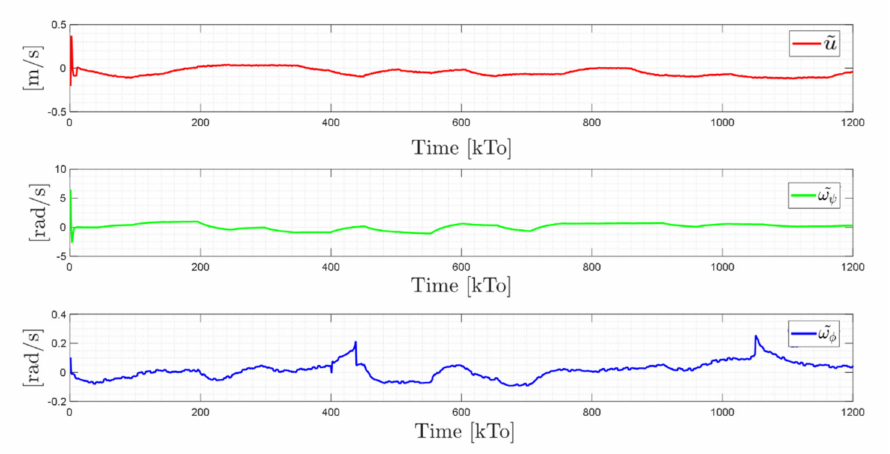
Figure 30. Time evolution of the control errors ˜ µ ( kT 0 ) = ( ˜ µ , ˜ ω ψ , ˜ ω φ ).